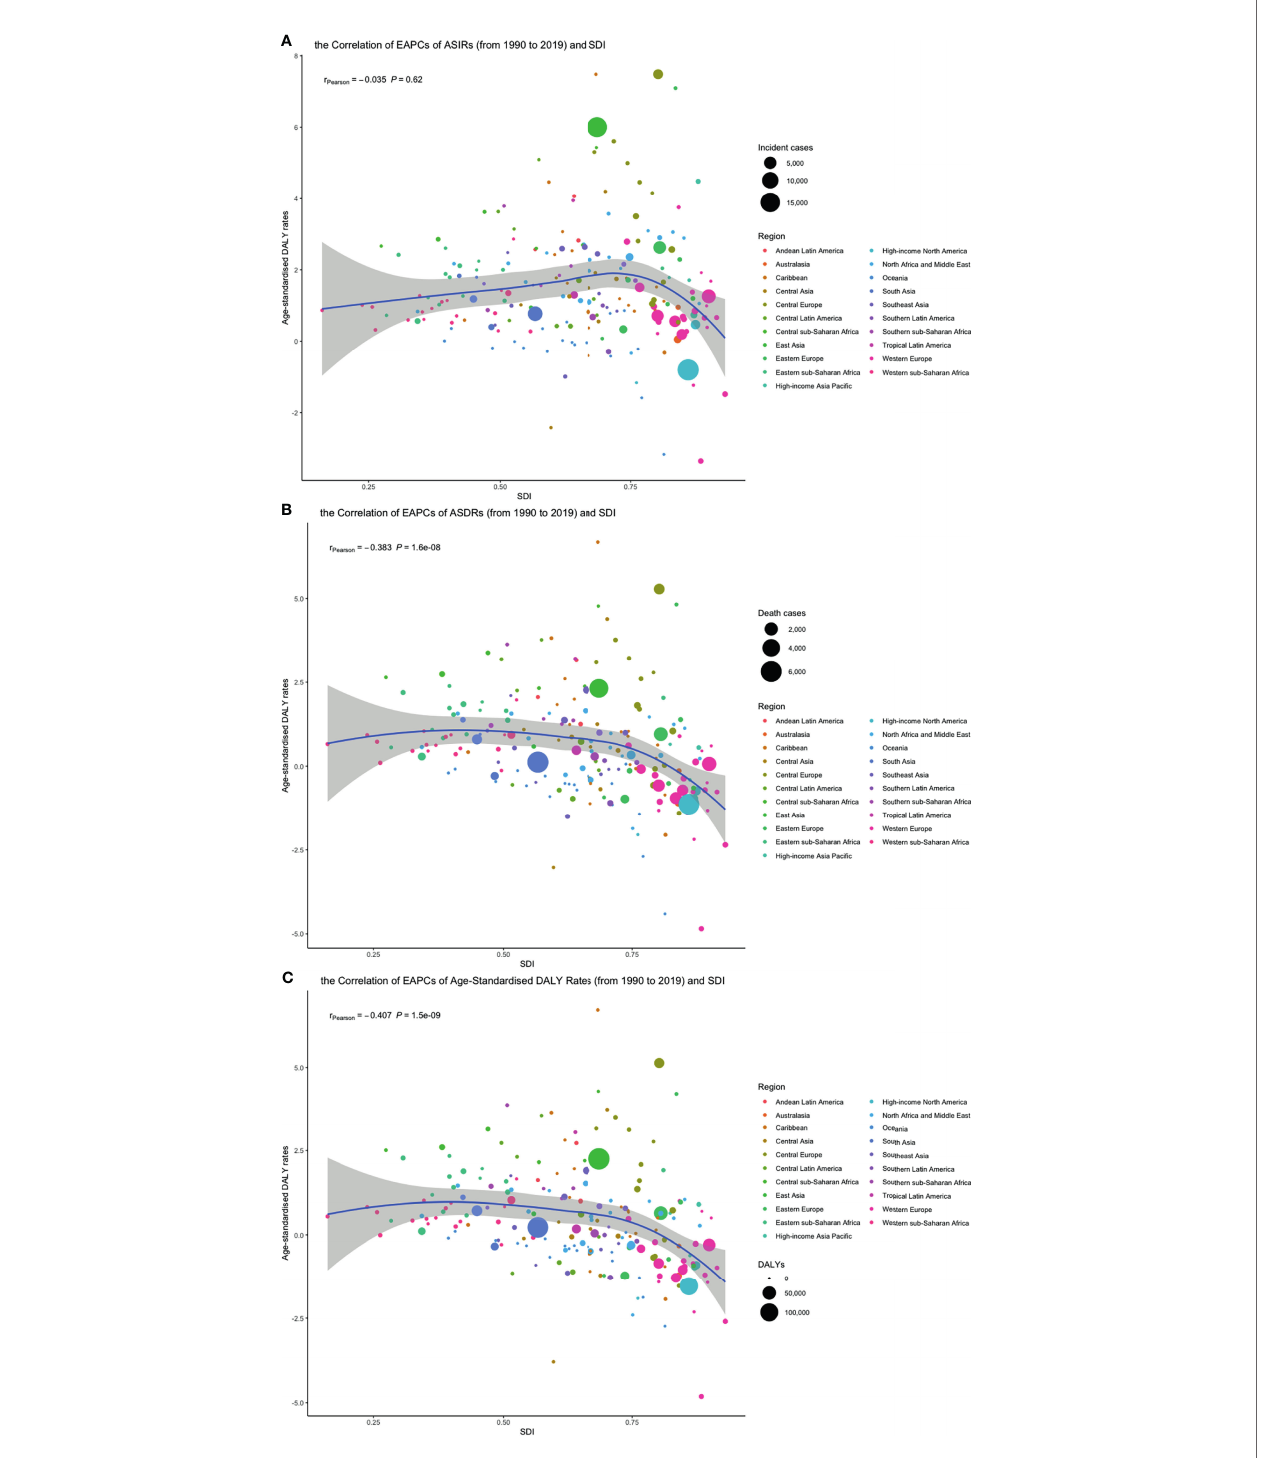
FIGURE 10 | The correlation between EAPCs of (A) ASIR, (B) ASDRs, and (C) age-standardized DALY rates from 1990 to 2019 and SDI in 2019. The circles represent 204 countries or territories, the size of circle represents the number of incident cases, death cases or DALY, and the color of circle represents the region which the country or territory belongs to. (ASIR, age-standardized incidence rate; ASDR, age-standardized death rate; DALY, disability-adjusted life year; SDI, socio- demographic index; EAPC, estimated annual percentage change, SDI, socio-demographic